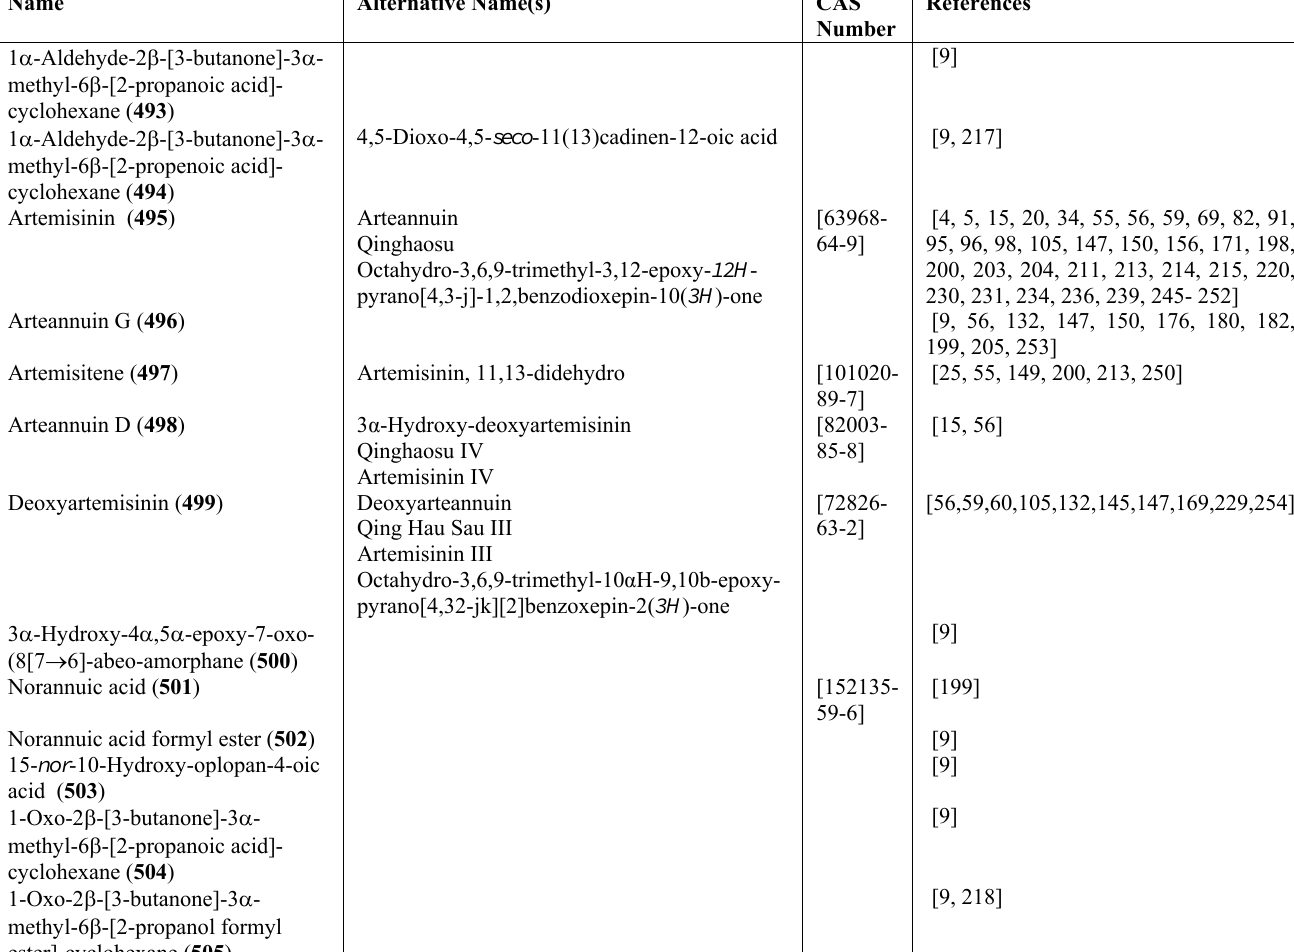
Table 38. Seco -Cadinane, nor -Cadinane and abeo -Cadinane